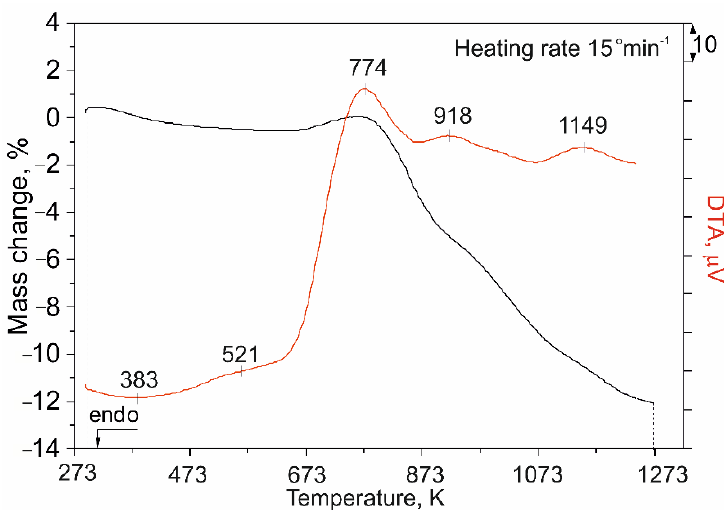
Figure 6. C omparative results of TG/DTA analysis for the investigated pentlandite ‐ bearing ore sam ‐ Figure 6. Comparative results of TG/DTA analysis for the investigated pentlandite-bearing ore ple.